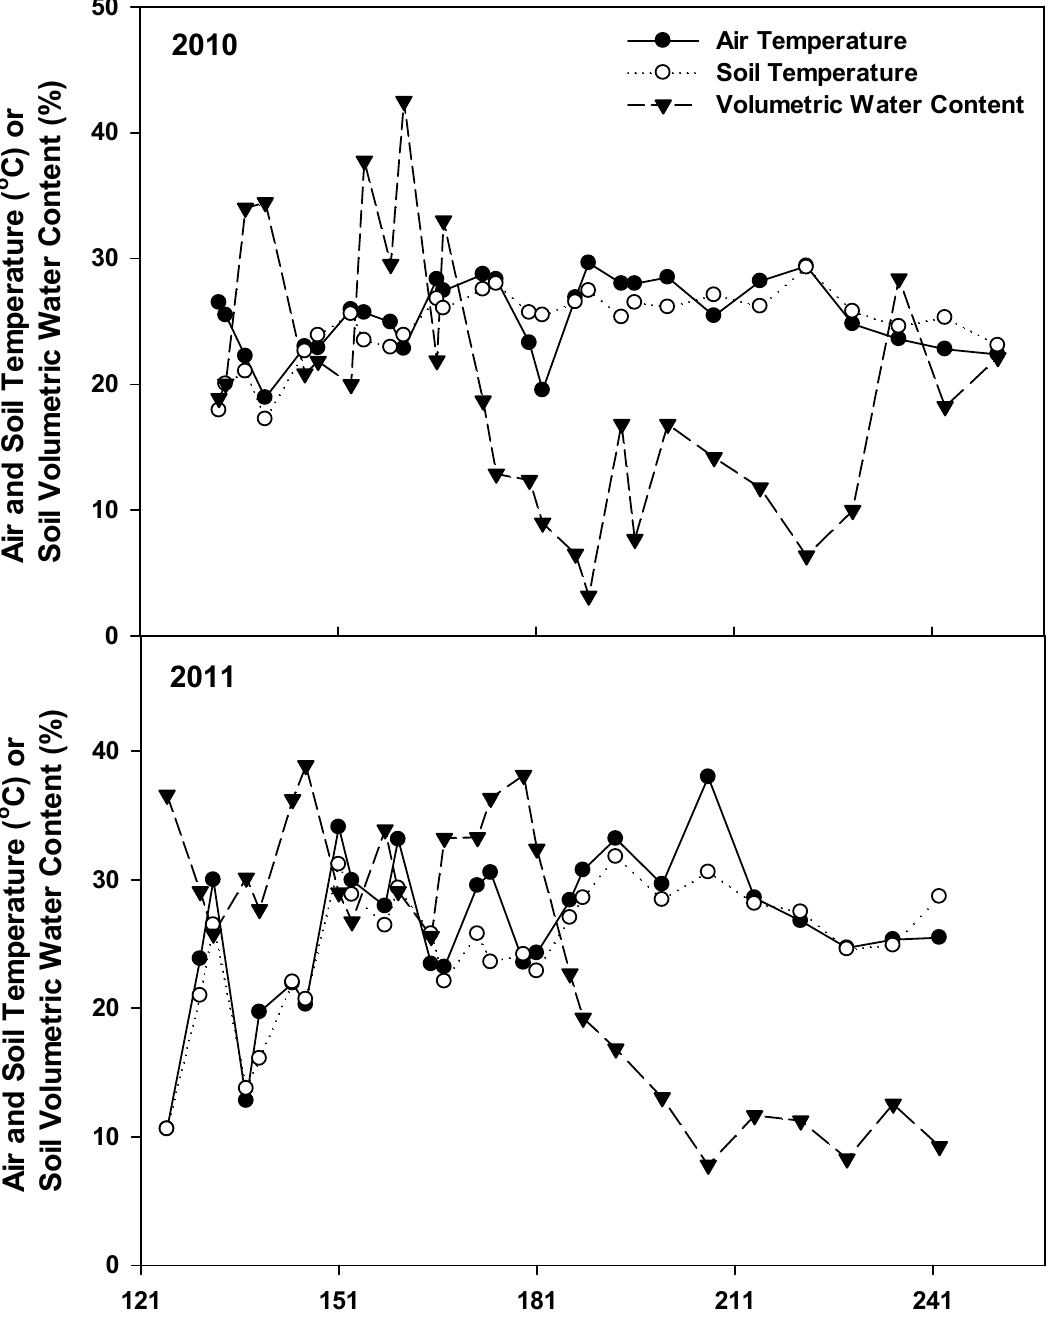
Figure 5. Air and soil temperature and soil moisture content measured during the first 2 years (2010 and 2011) of the study.